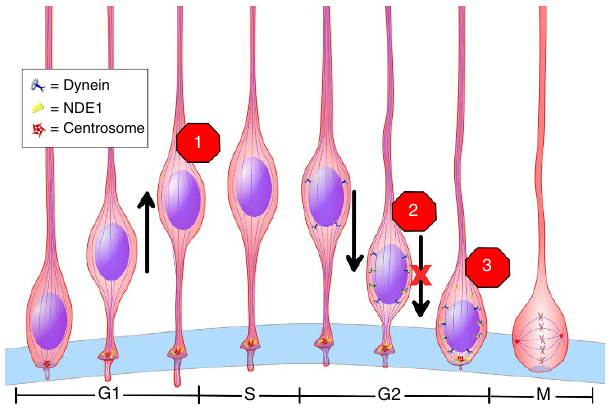
Figure 9 | Roles of NDE1 and NDEL1 in the neural progenitor cell cycle. Our data indicate that NDE1 is required for three distinct non-mitotic processes in the radial glia progenitor (RGP) cell cycle: G1-to-S progression (1), apical INM during late G2 (2) and G2-to-M transition (3). NDEL1 overexpression rescues (1) and (2), but not (3). Interference with the RGP cell cycle at any or all of these stages is proposed as an important contributor to microcephaly. Scale of image does not reflect actual duration of cell cycle